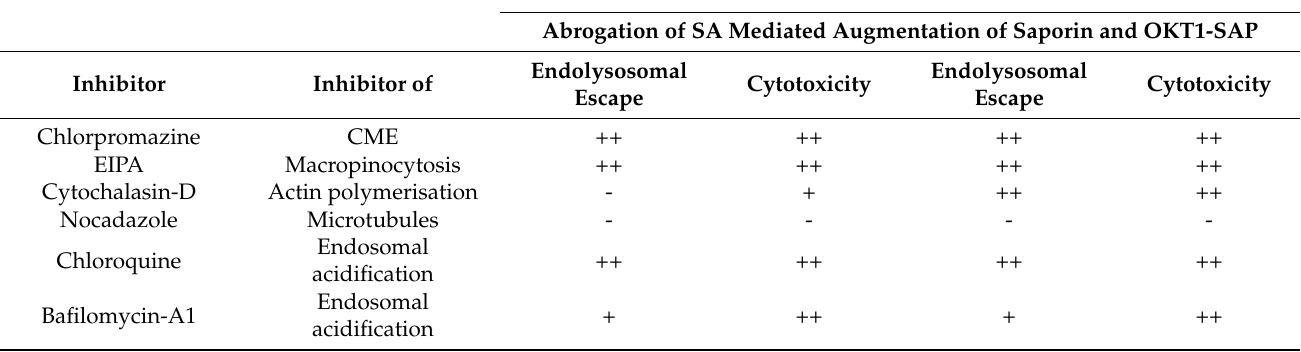
Table 1. The abrogatory effects of small molecule inhibitors on the endolysosomal escape of Saporin and OKT10-SAP in Daudi and HSB-2 cells. Strong abrogation (++), partial abrogation (+), no abrogation ( − ). Daudi HSB-2 Abrogation of SA Mediated Augmentation of Saporin and